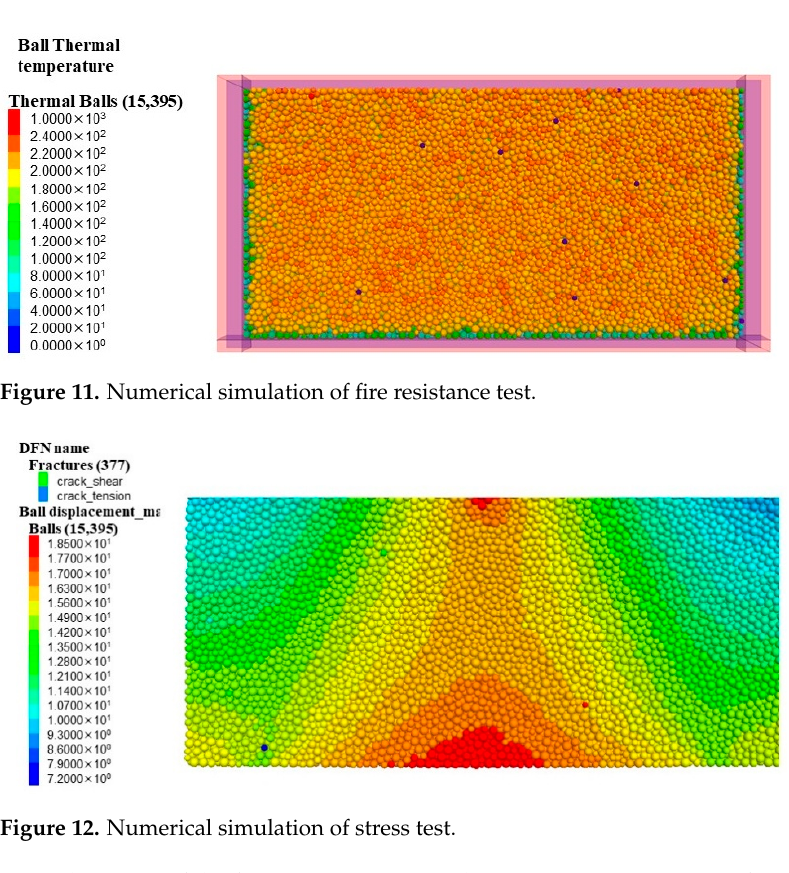
Figure 10. Numerical simulation model. The numerical simulation results are shown in Figures 11 and 12.